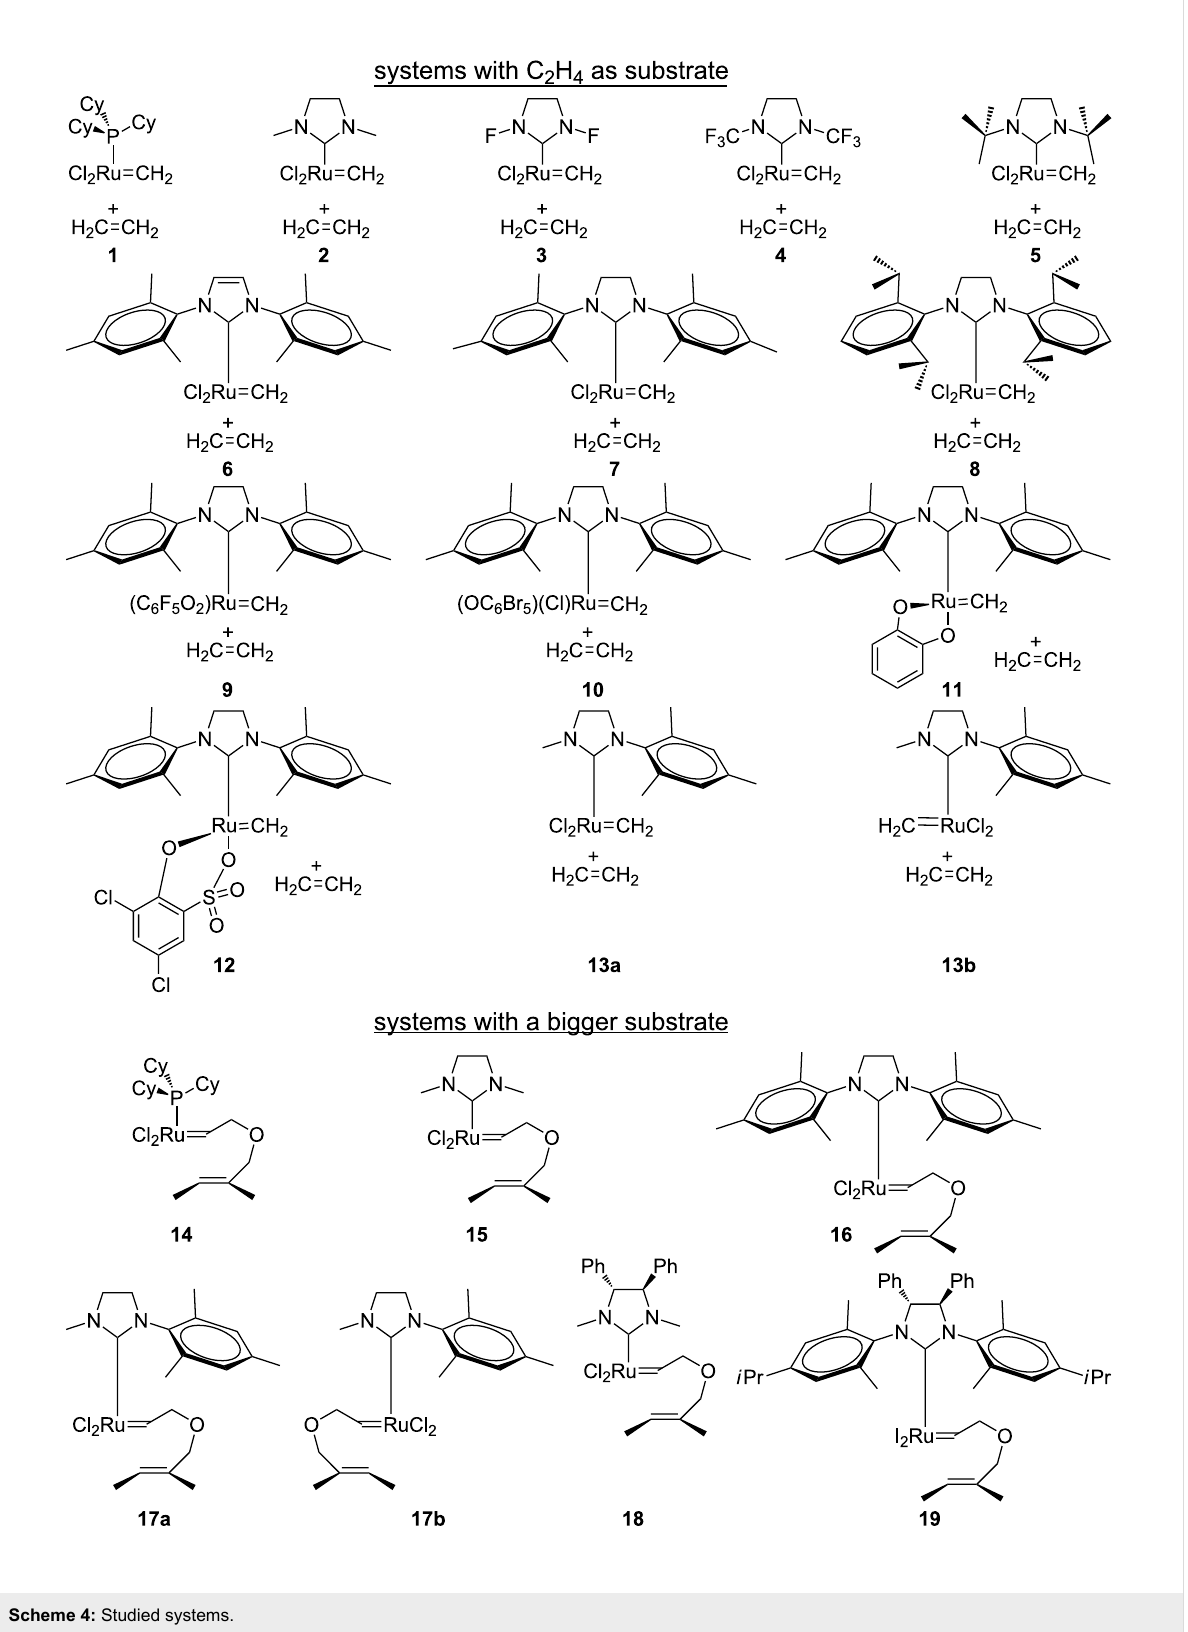
Scheme 4: Studied